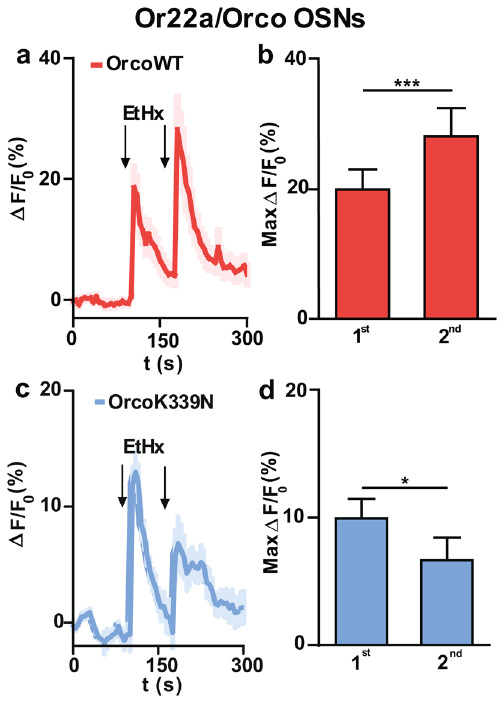
Figure 5. Effect of Orco CBS mutation on the sensitization in Or22a/Orco expressing OSNs. (a) Time course of Ca 2+ fluorescence response (∆F/F 0 (%)) in OrcoWT OSNs upon OR stimulation with 0.05 µM ethyl hexanoate (n = 14). (b) Intensity of 1st and 2nd Ca 2+ fluorescence responses (∆F/F 0 (%)) for OrcoWT OSNs. (c) Time course of Ca 2+ fluorescence response (∆F/F 0 (%)) in OrcoK339N OSNs upon OR stimulation with 0.5 µM ethyl hexanoate (n = 12). (d) Intensity of 1st and 2nd Ca 2+ fluorescence responses (∆F/F 0 (%)) for OrcoK339N OSNs. Intensity of 1st and 2nd response was calculated by subtracting the base level from the maximum Ca 2+ fluorescence. In case of sensitization, the 2nd response is significantly higher than 1st response. n = cell bodies. Two-tailed paired t- test, * P < 0.05, *** P < 0.001. Data given as mean ±